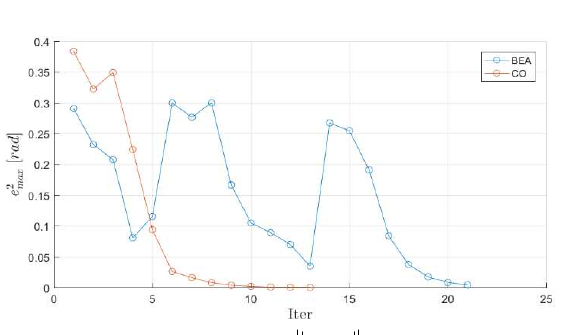
2 e through max